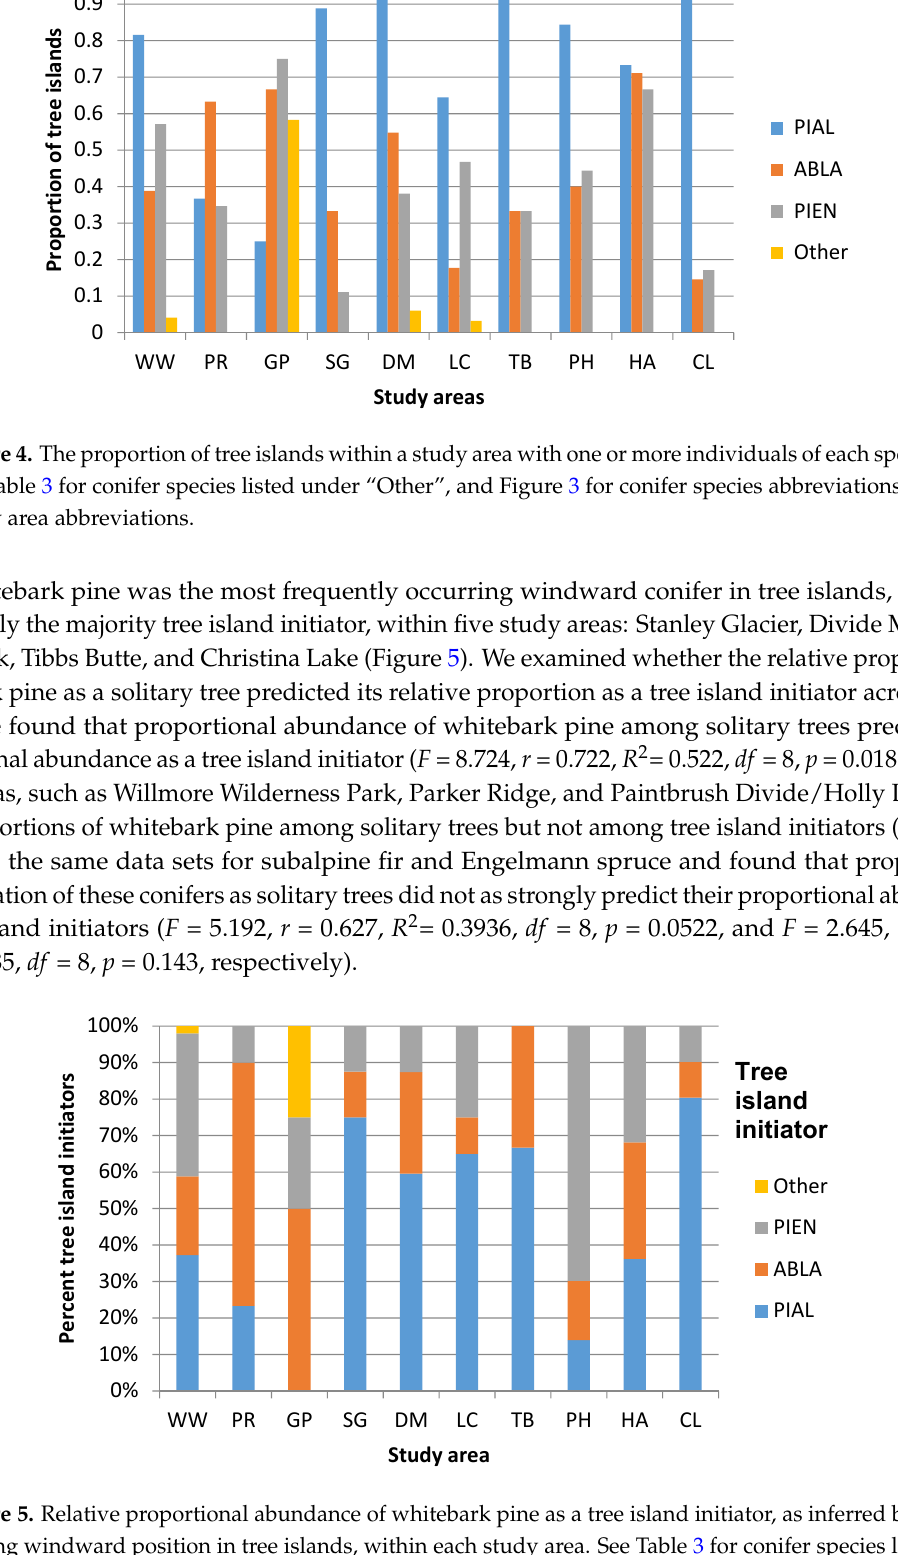
= whitebark pine ( Pinus albicaulis ), ABLA = subalpine fir ( Abies lasiocarpa ), PIEN = Engelmann spruce